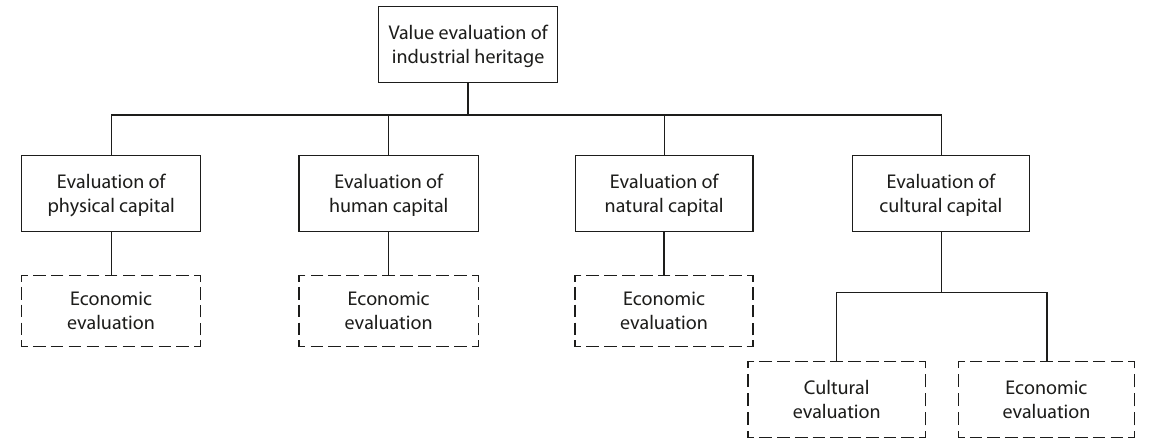
Figure 4 Classification of value evaluation of industrial heritage (Source: Subin